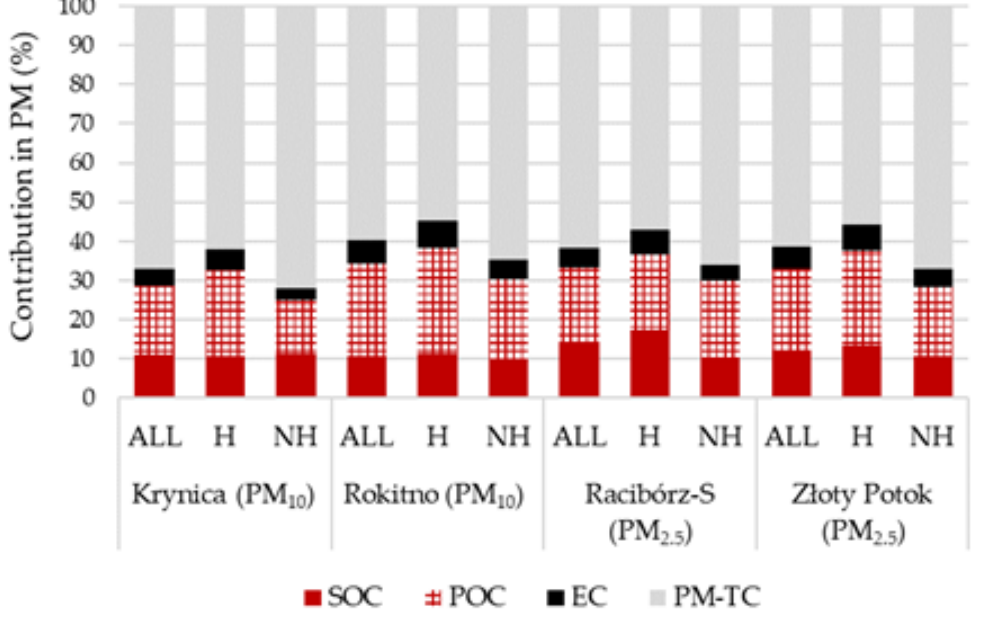
Figure 6. Average contributions of carbonaceous compounds (EC, SO, POC) in PM mass (%) at considered rural background sites.